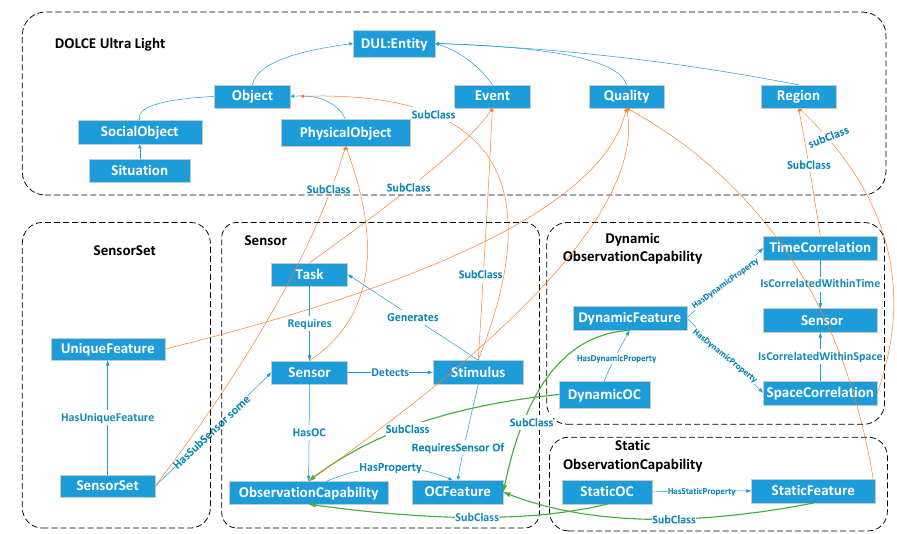
Figure 3. The SOCA ontology modules, core classes and relations aligned to DOLCE. Sensor Module